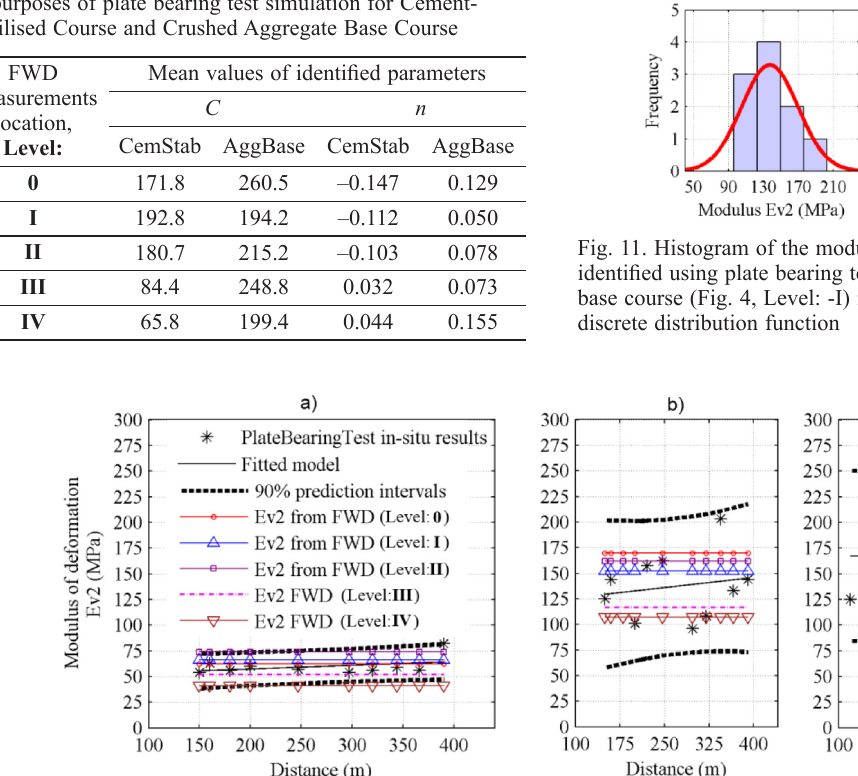
Fig. 10. Ev2 modulus values for both, analytical model (based on mean C and n values, identified from deflection basin measurements) and in-situ SPB test measurements: a) Level -II: Cement-Stabilised Course – STAGE 1; b) Level -I: Crushed Aggregate Improved Subgrade Course – STAGE 2; c) Level 0 : Crushed Aggregate Base Course